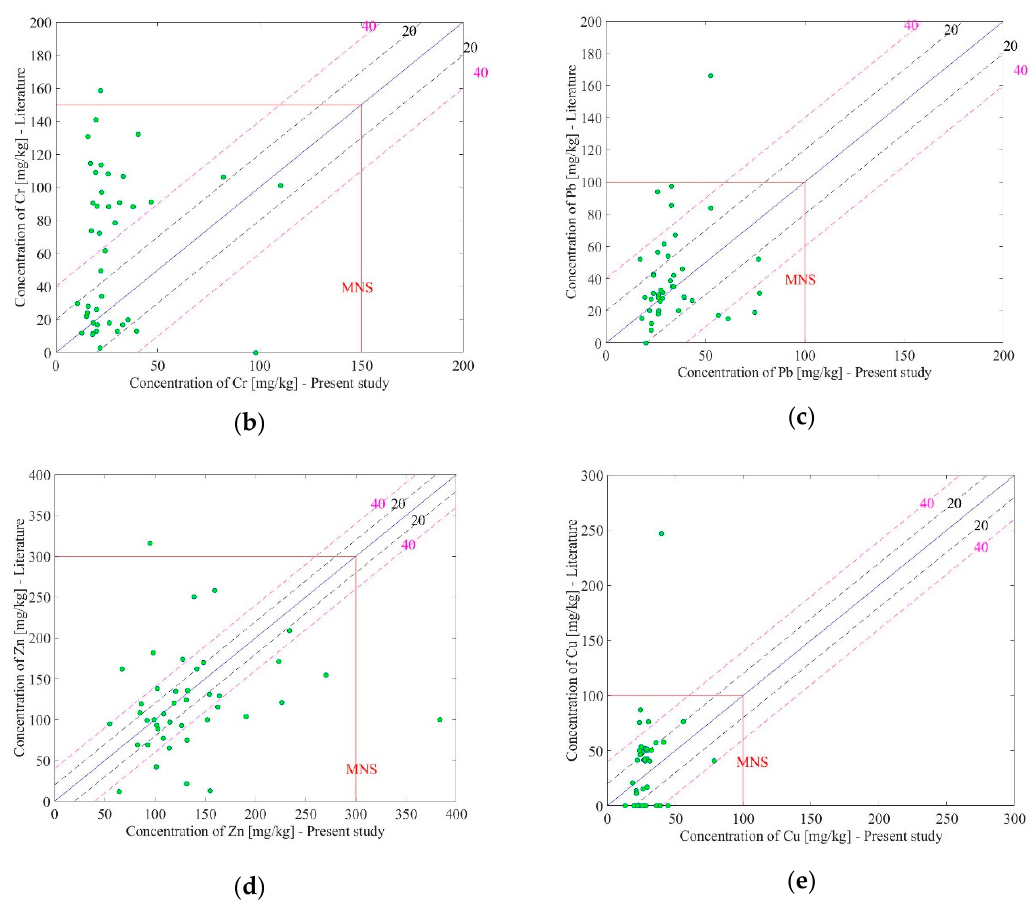
Figure 3. Comparison between the present and literature data on heavy metal concentration. ( a ) Concentration of As; ( b ) Concentration of Cr; ( c ) Concentration of Pb; ( d ) Concentration of Zn; ( e ) Concentration of Cu.